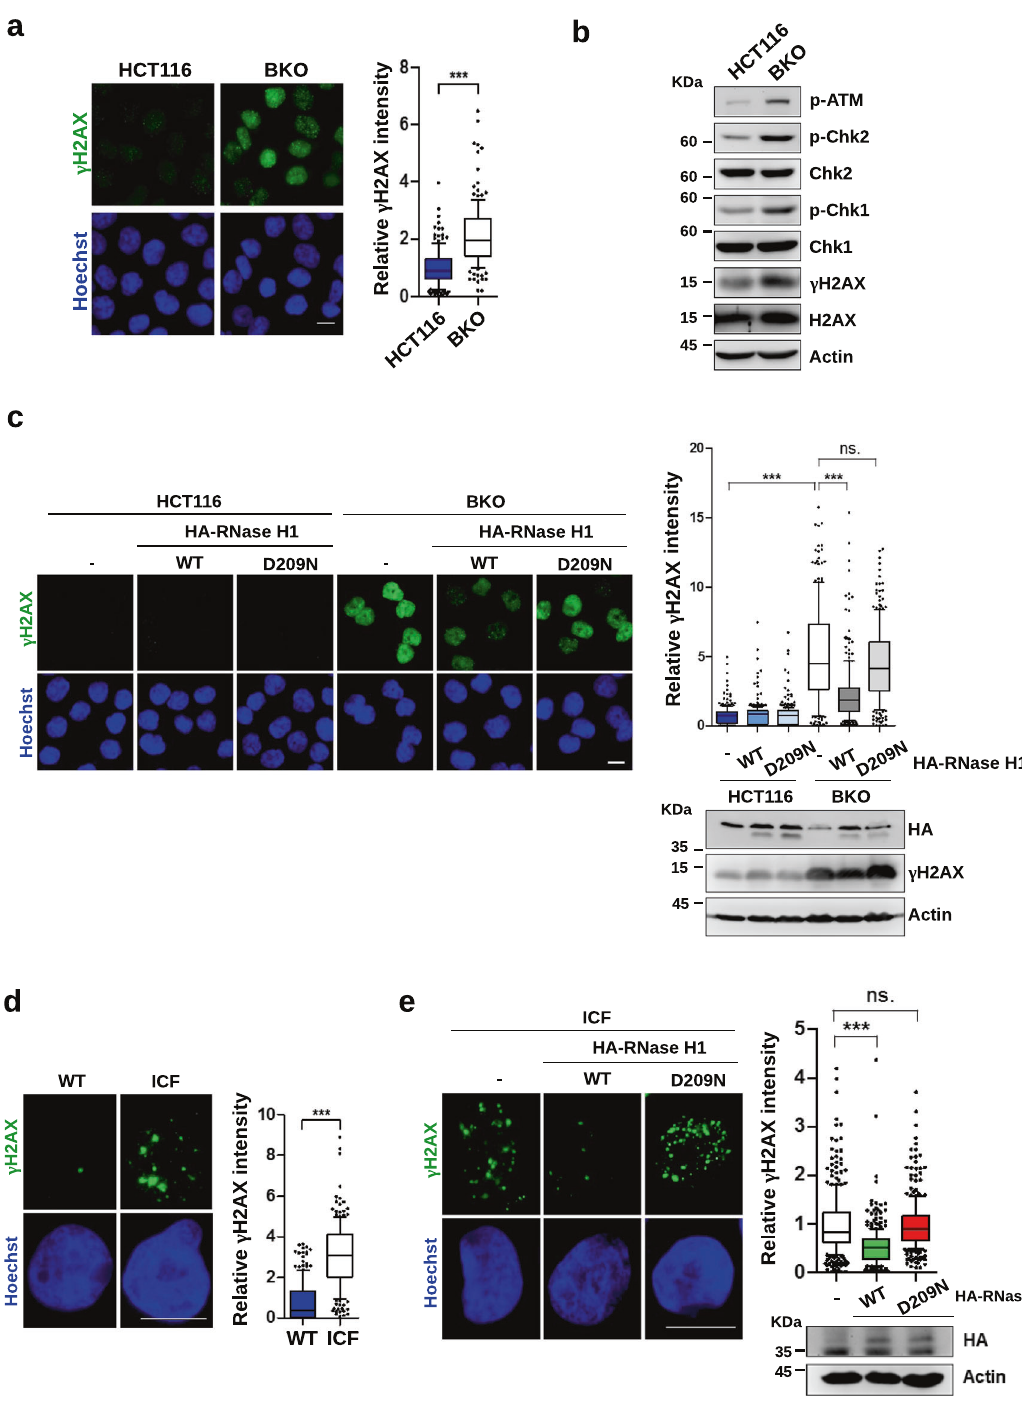
Fig. 1 R-loops are the sources of DNA damage in BKO and ICF cells. a , b HCT116 and BKO cells were fi xed for a γ H2AX IF staining (scale bar, 10 μ m). The relative intensity of γ H2AX in cells ( n > 150) from three independent experiments is expressed, *** P < 0.001 by the Mann – Whitney test. b Western blot analysis of DNA damage response markers. c γ H2AX IF staining of HCT116 and BKO cells that were infected with retrovirus of empty HA-vector, HA-RNaseH1-WT, and HA-RNaseH1-D209N (scale bar, 10 μ m, left ). Relative fl uorescent intensity of γ H2AX in cells ( n > 150) from three independent experiments ( upper right) . Western blot of the expression of HA-RNase H1 ( bottom right) . d The comparison of DNA damage signal in wild-type versus ICF LCL. Cells were fi xed for IF staining by γ H2AX antibody (scale bar, 10 μ m). The relative intensity of γ H2AX in cells ( n = 100) from three independent experiments. e ICF LCLs were infected with retrovirus of empty HA-vector, HA-RNaseH1-WT, and HA- RNaseH1-D209N for γ H2AX IF staining (scale bar, 10 μ m, Left ). Relative fl uorescent intensity of γ H2AX in cells ( n = 100) from three independent experiments ( upper right) . Western blot analysis of HA-RNaseH1-WT and HA-RNaseH1-D209N ( bottom right ).